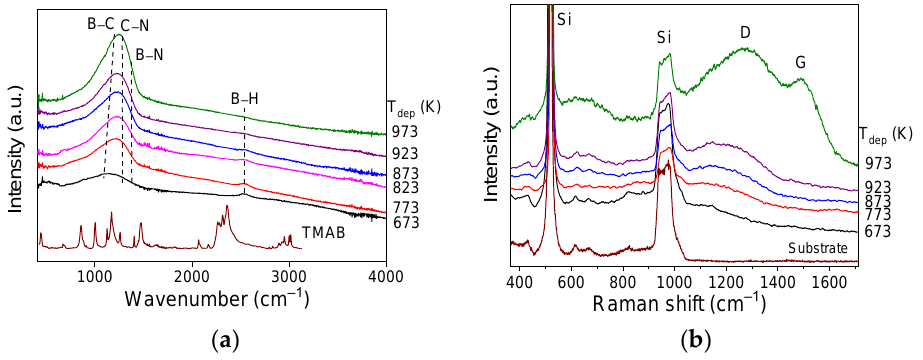
Figure 6. Evolution of ( a ) FTIR spectra and ( b ) Raman spectra of BC x N y films obtained by LPCVD using TMAB + N 2 mixture.